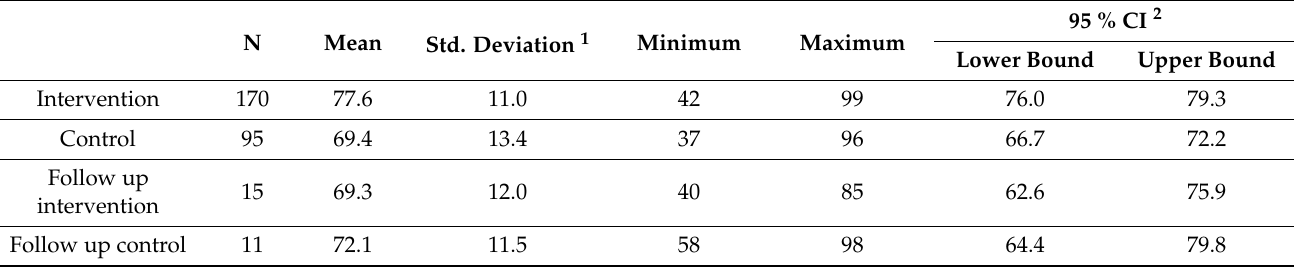
Table 2. Differences between study groups.